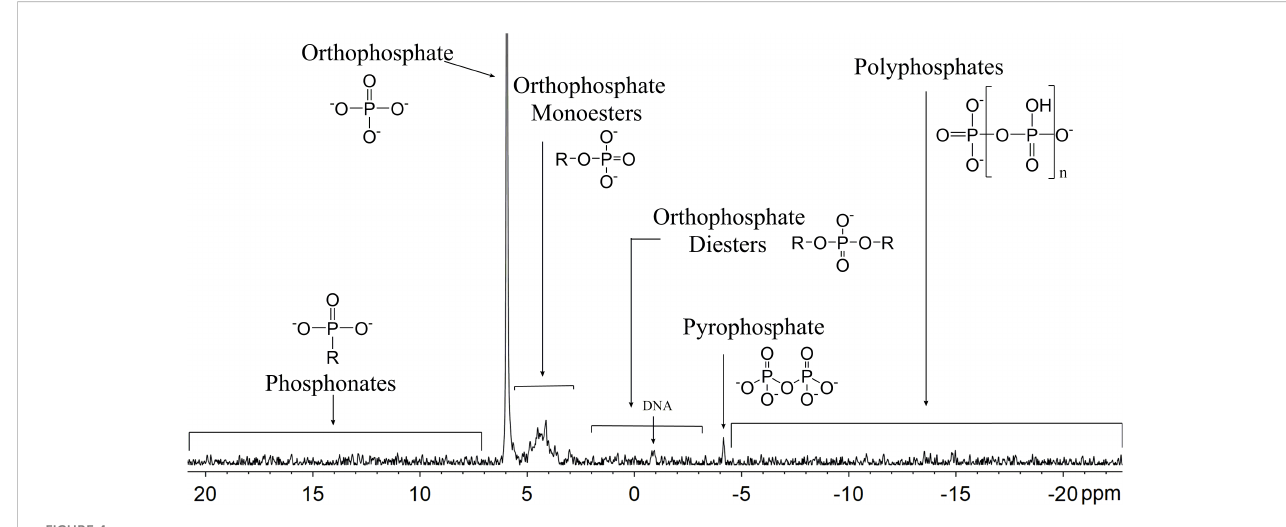
FIGURE 4 Examples of solution 31 P nuclear magnetic resonance spectra for all treatments.